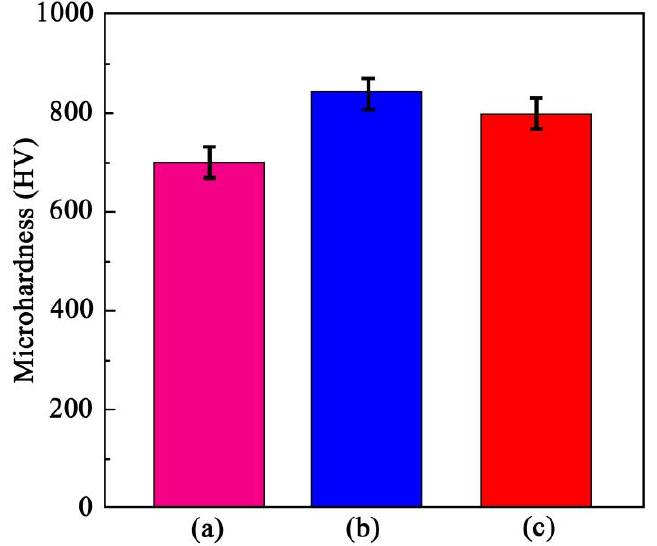
Figure 7. Influence of pulse current density on microhardness for Ni/TiN-SiC nanocomposites. ( a ) Composite obtained at 2 A/dm 2 , ( b ) Composite obtained at 4 A/dm 2 , and ( c ) Composite obtained at 6 A/dm 2 .